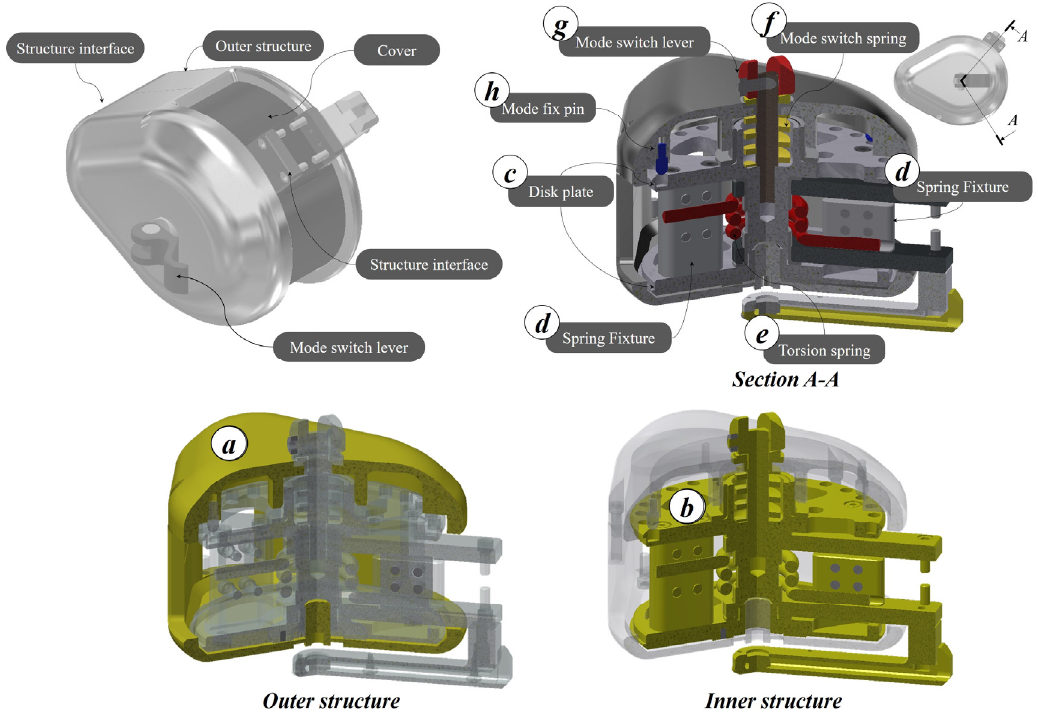
Figure 6. Detailed illustration of the designed gravity compensation module.